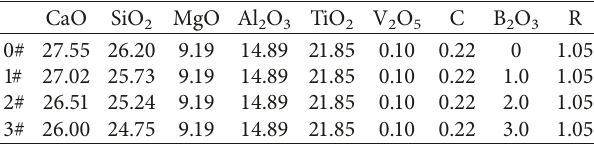
Table 1: The chemical compositions of samples